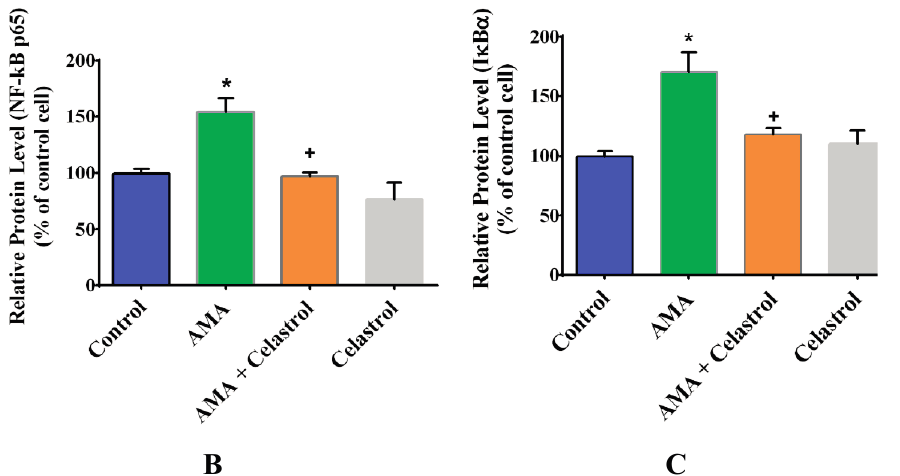
B C Figure 7. AMA treatment of human myotubes in the absence and presence of celastrol. Cells were grown in 6-well plates and treated with AMA and celastrol for 48 h. The representative images of western blot analysis ( A ) of the relative expression level of NF- κ B ( B ) and I κ B α ( C ) activity was measured and quantified. β -actin was used as a loading control. Protein levels calculated by densitometry were normalized relative to β -actin signals. * p < 0.05 vs . untreated control; + p < 0.05 vs . AMA-treated